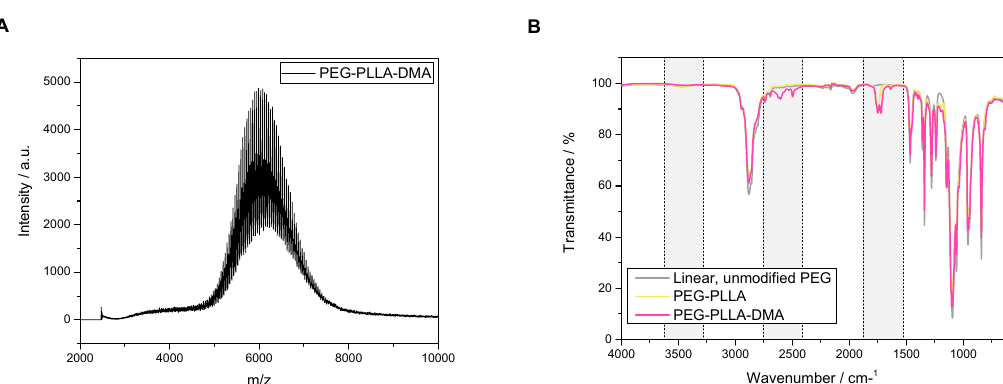
Figure 1. MALDI-ToF analysis ( A ) and FTIR spectra ( B ) of the synthesized PEG-PLLA-DMA cross-linker. PEG-PLLA-DMA: dimethacrylated poly(ethylene glycol)-poly(lactide).